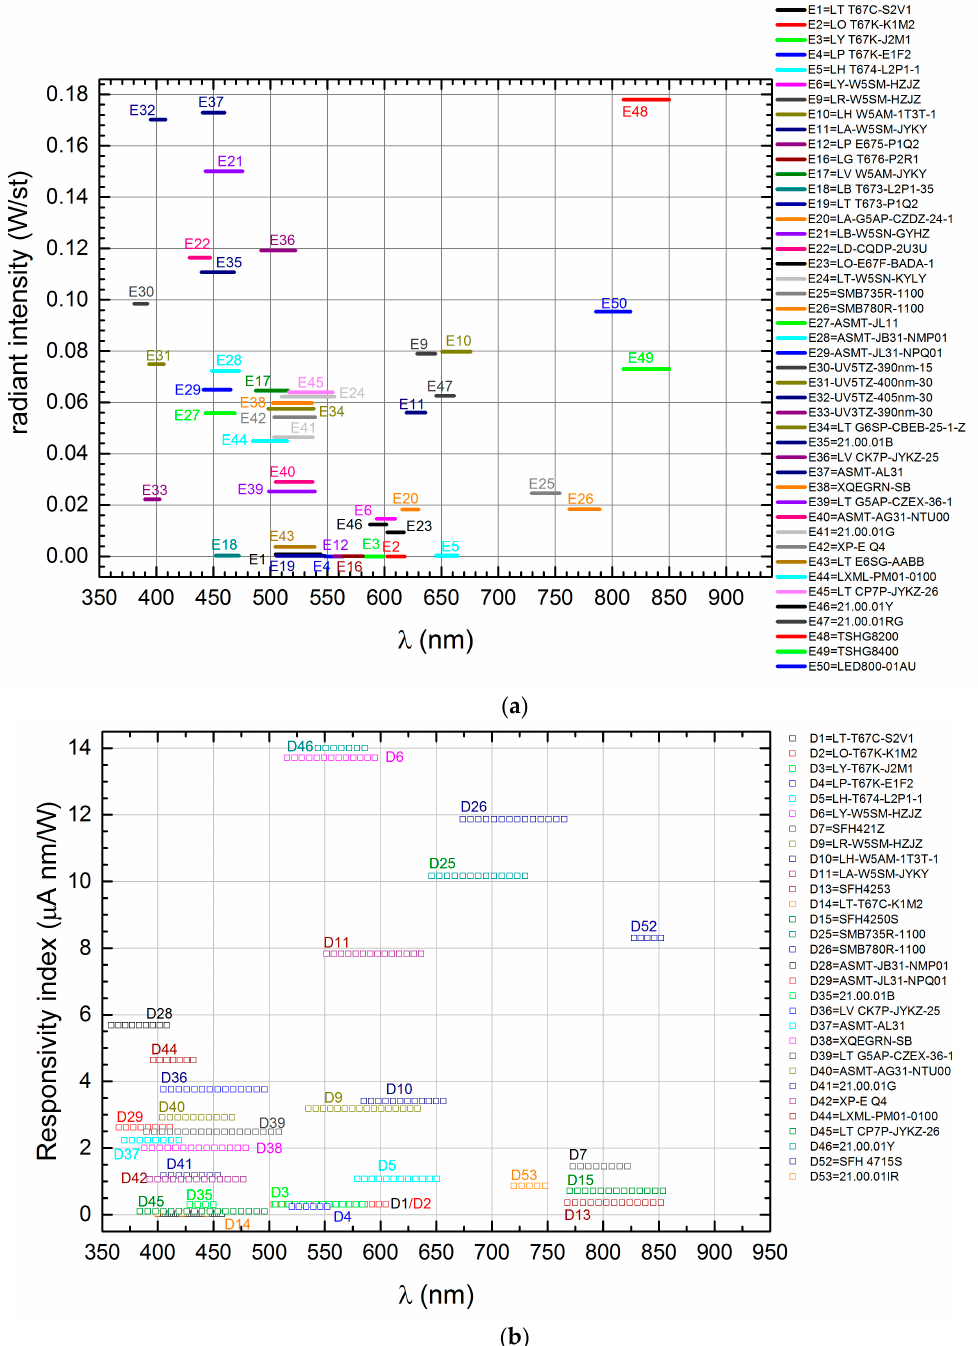
Figure 5. Representation of: ( a ) the Radiant intensity of LEDs used as radiation sources, and ( b ) the Responsivity index of LEDs used as radiation sensors. In both diagrams, the length of the segments corresponds to the FWHM, while in ( b ) the numerical value is the integral of the photocurrent over the FWHM.